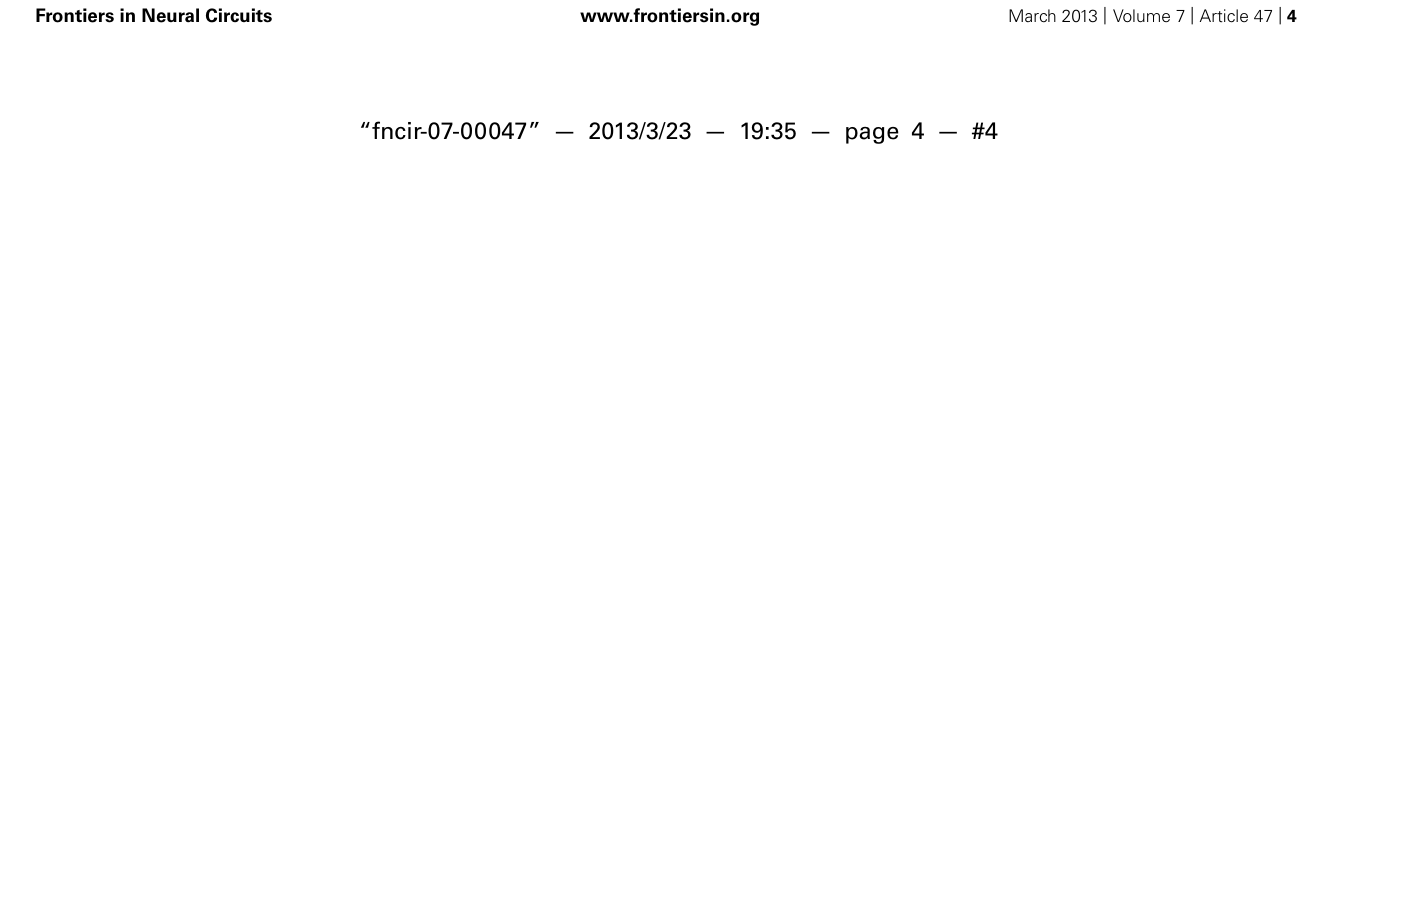
times. Both in (A) and (B) , red and green lateralis afferents belong to the first neuronal subclass which projects dorsal axons that contact the Mauthner cell. Red and green neurons innervate posterior and anterior primary neuromasts, respectively. Blue lateralis afferents belong to the second neuronal subclass which projects ventrolateral axons that do not contact the Mauthner cell.The two neuronal subclasses form a dimorphic neural map (DI) whereas only the neurons of the first subclass shape the somatotopic map (S). Neurons in red are the first-born neurons whereas neurons in blue are the latest-born neurons. primI, first primordium; primD, dorsal primordium; primII, second primordium. L1,Terminal and D1 neuromasts are primary and parallel ( > ). LII.1 and D2 neuromasts are secondary and perpendicular ( ∧